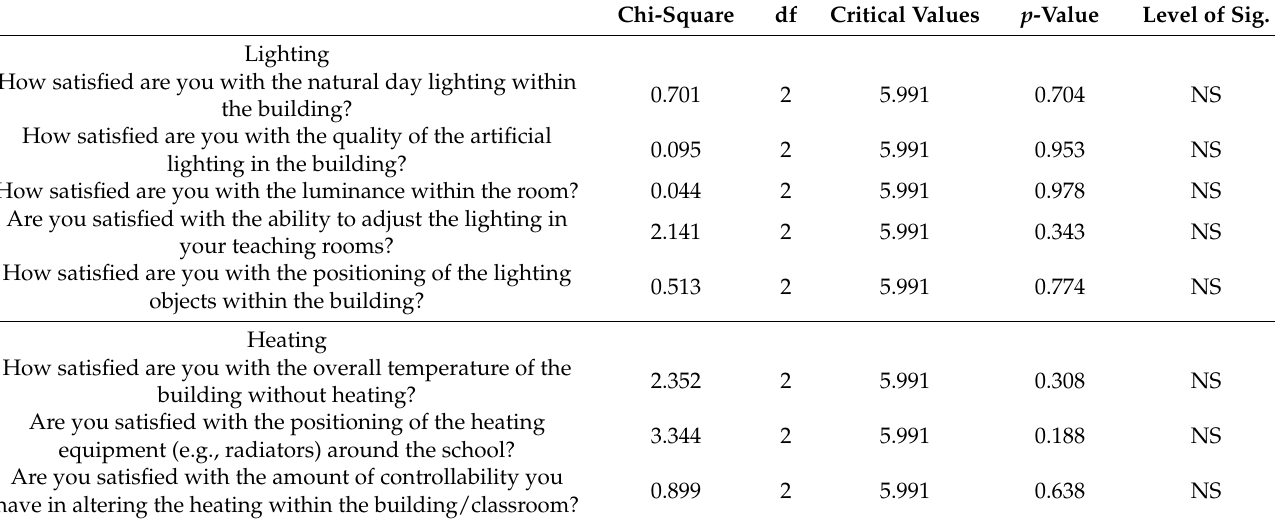
Table 5. Kruskal–Wallis Test statistics a,b of the three schools